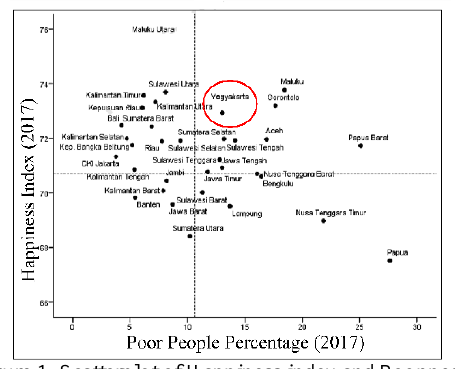
Figure 1. Scatterplot of Happiness index and Poor people percentage by province in Indonesia Source: BPS 2017 Figure 2. Map of Special Region of Yogyakarta (DIY) Province